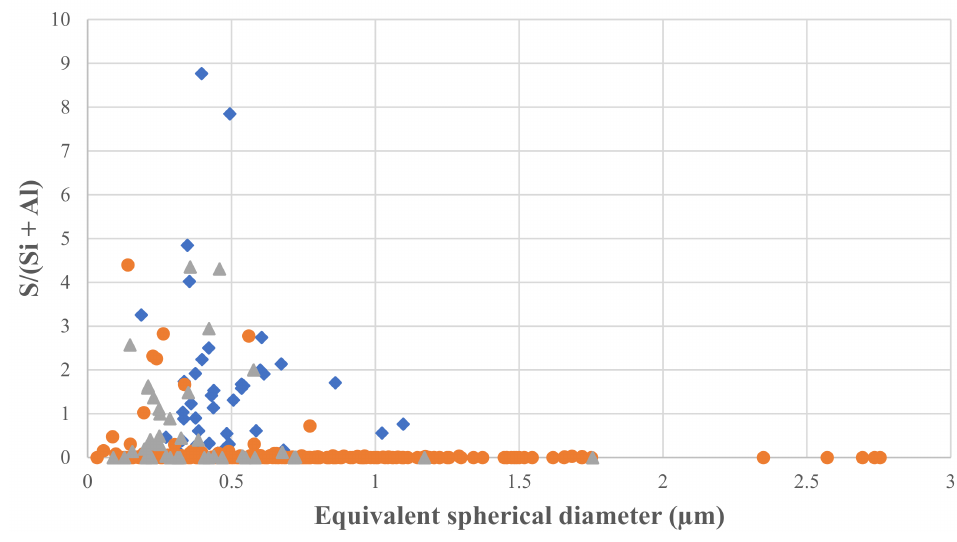
Figure 9. The value of S/(Si + Al) in individual particles as a function of particle